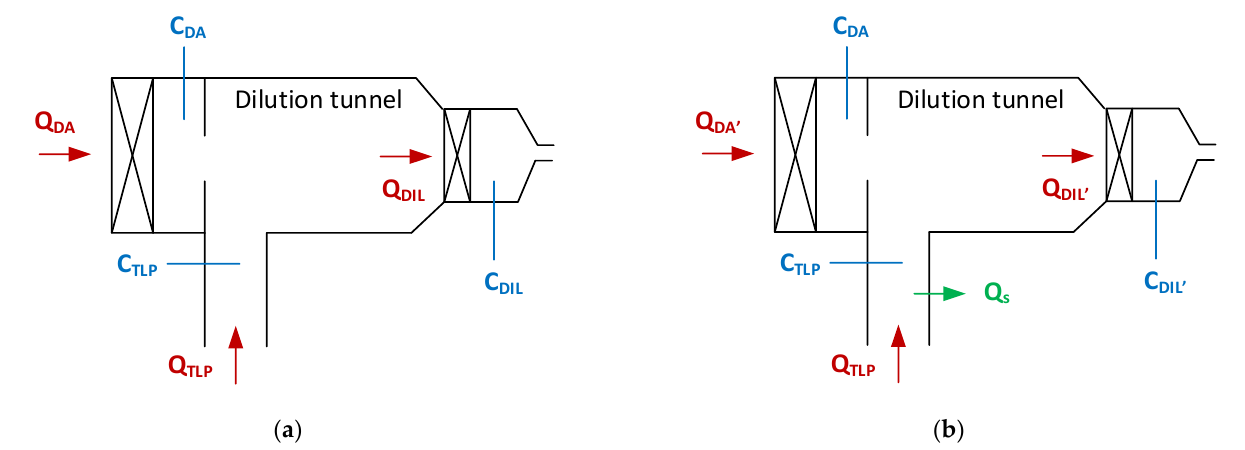
Figure A1. Impact of extracted flow Qs on concentrations and flows: ( a ) no extracted flow; ( b ) with extracted flow from the tailpipe.